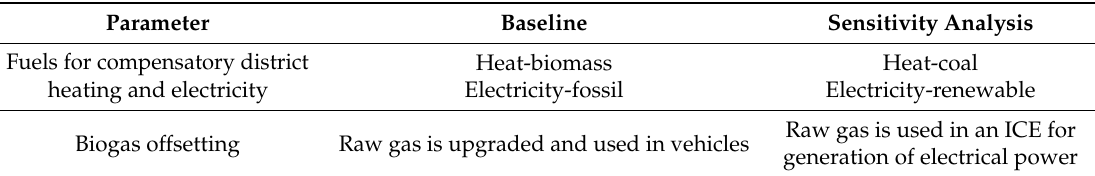
Table 3. Parameters changed in sensitivity analysis. ICE: internal combustion engine.